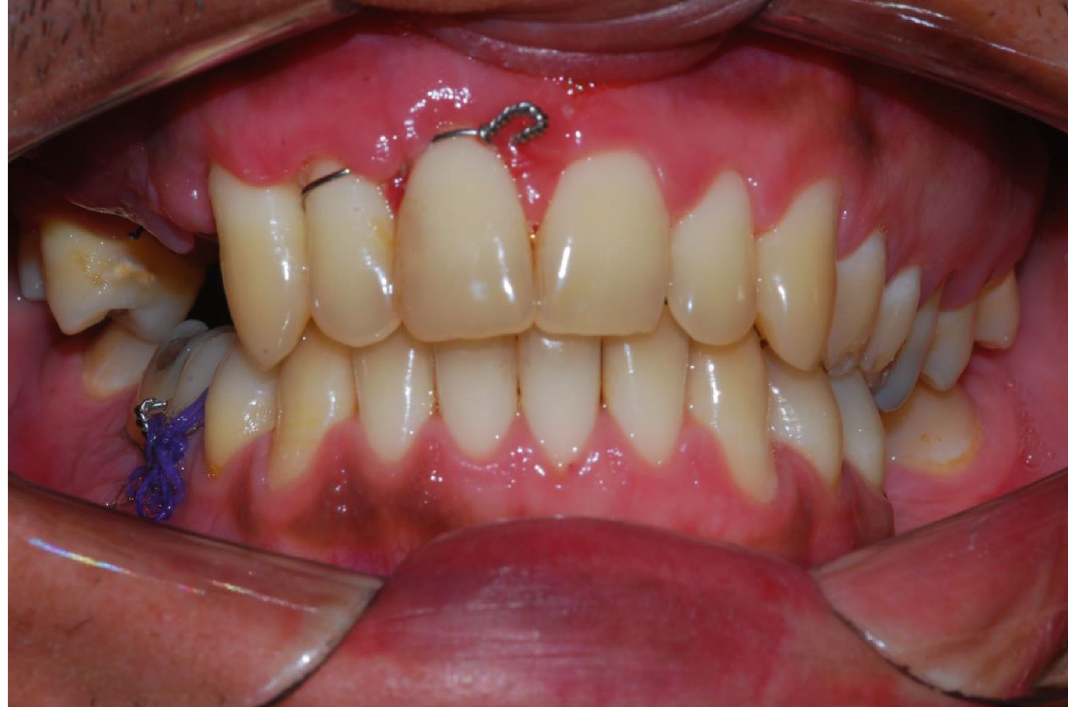
Figure 11: Postoperative appearance of 7 days, good healing aspect of the surgical approach, suture stitches in position, and reestablishment of functional